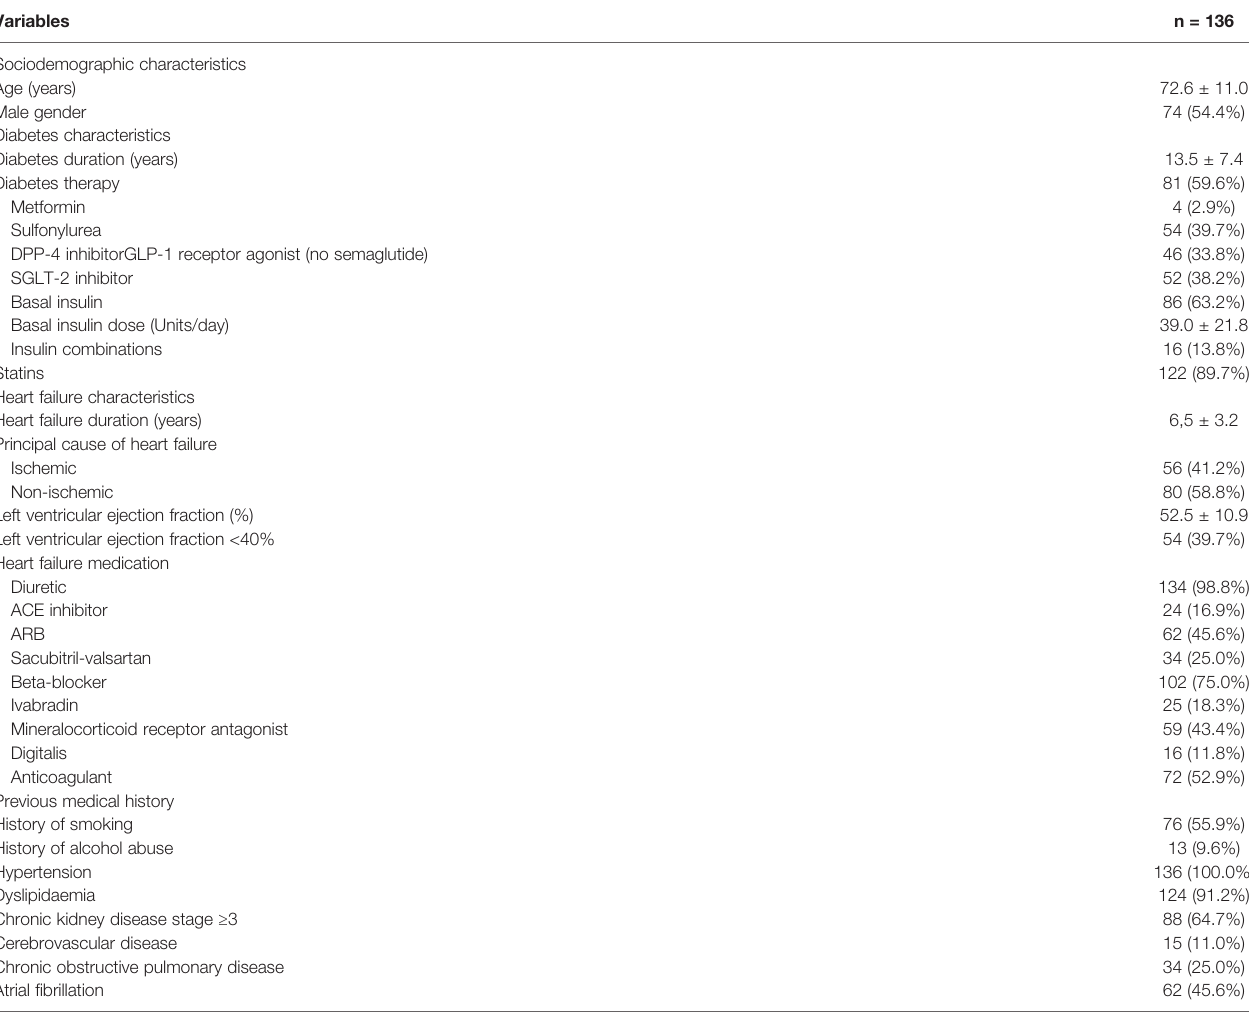
TABLE 1 | Baseline sociodemographic and clinical-therapeutic characteristics.